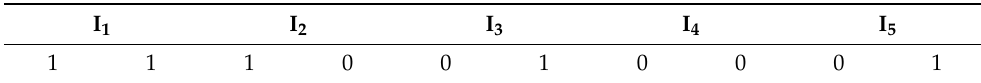
Table 1. Randomly generated Michigan-coded